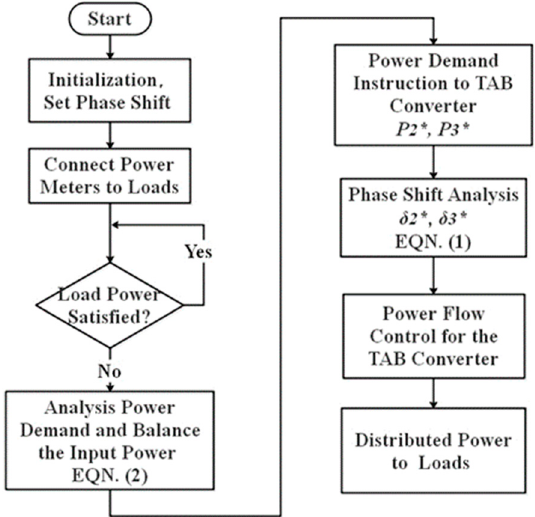
Figure 6. Methodology flow chart of power balancing and power flow control.